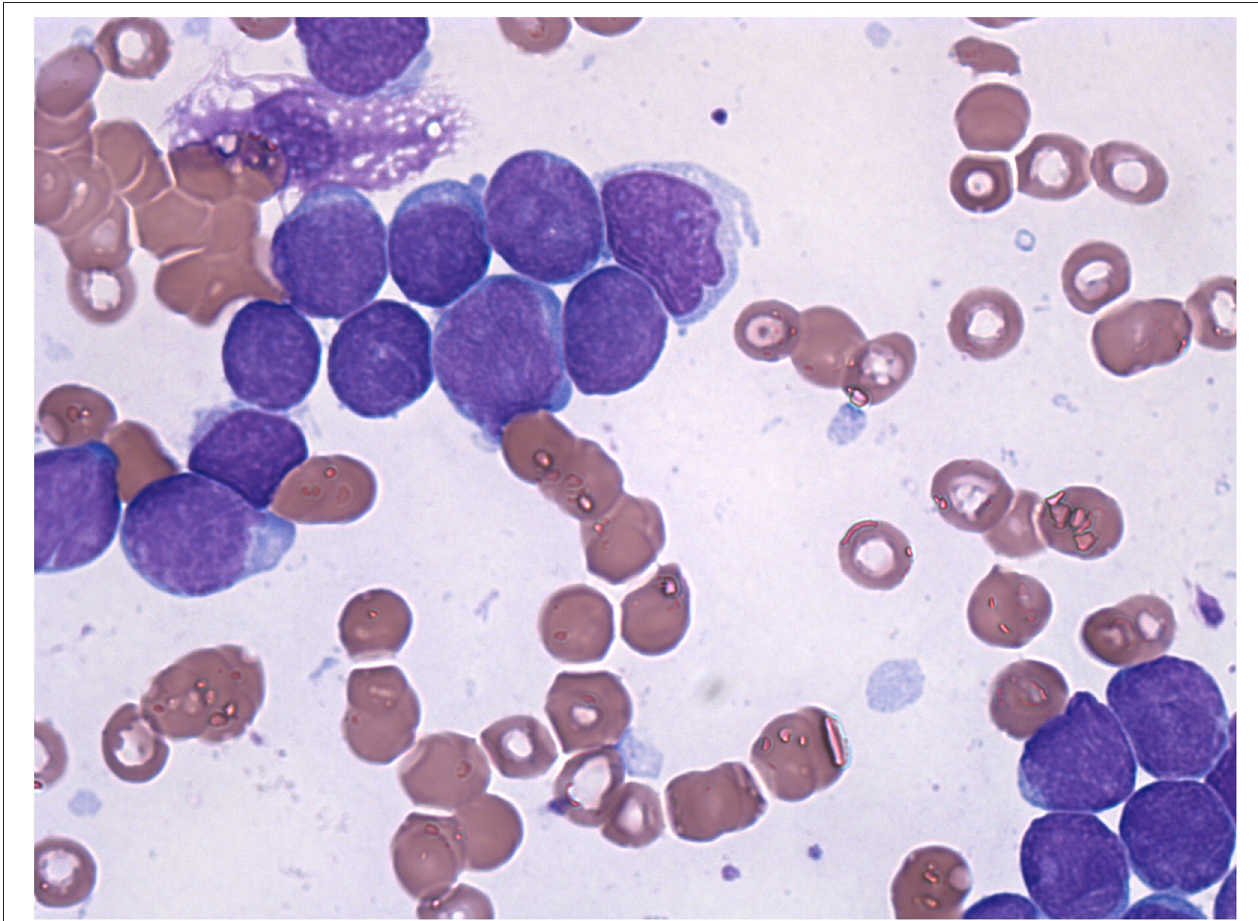
FIGURE 2 | Morphological analysis of the bone marrow aspirate shows rich cellularity, more than 90% of which is replaced by blastic elements with a probably lymphoid habitus and a high nucleus/cytoplasm ratio.